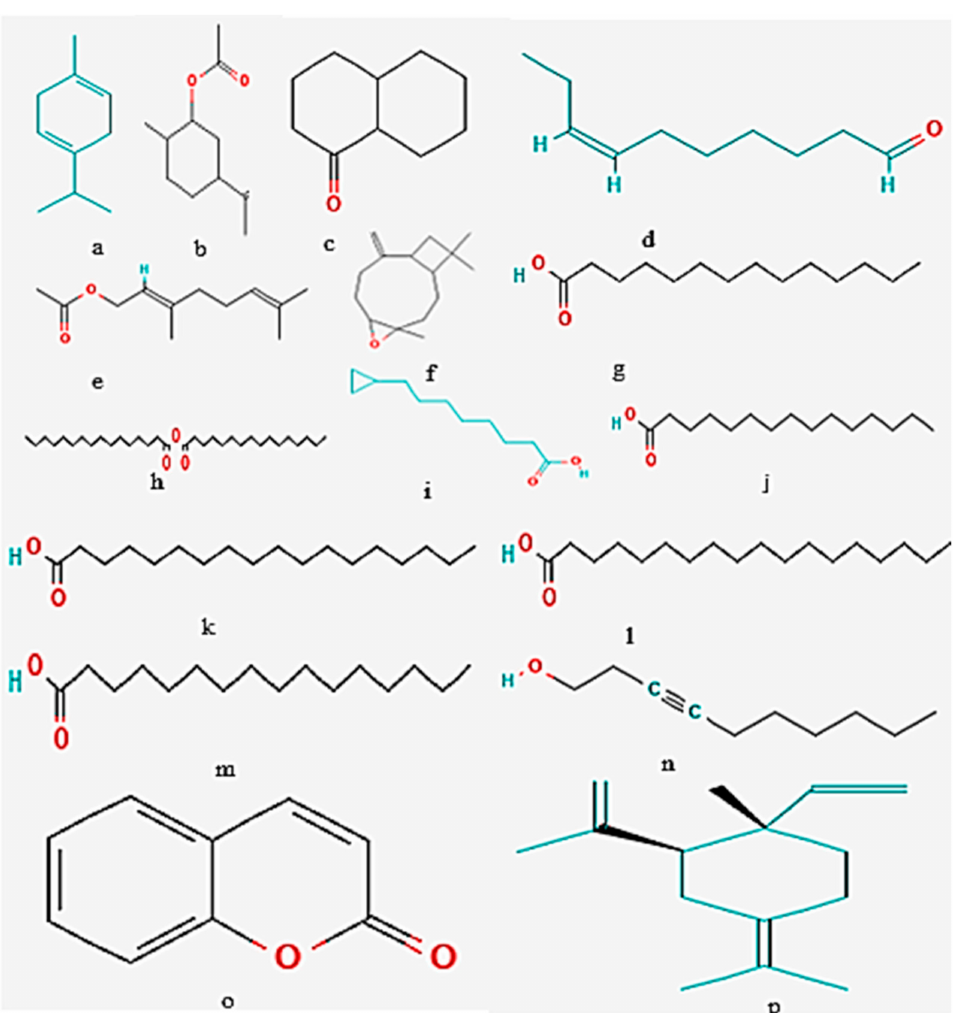
Figure 2. Chemical structure of bioactive components isolated from Woodfordia fruticosa flower extract ( a ) γ –Terpinene, ( b ) Dihydrocarvyl acetate, ( c ) 1-Decalone (cis-trans), ( d ) cis-7-Decen-1- al, ( e ) 2,6-Octadien-1-ol, 3,7-dimethyl-acetate, ( E )-(Geranyl acetate), ( f ) Caryophyllene Epoxide, ( g ) Tetradecanoic acid, ( h ) Palmitic anhydride, ( i ) Cyclopropaneoctanoic acid, ( j ) Pentadecanoic acid, ( k ) Pentadecanoic acid, ( l ) Octadecanoic acid, ( m ) n- Hexadecanoic acid ( n ) 3-Decyn-1-ol, ( o ) 2H-1-Benzopyran-2-one, and ( p )